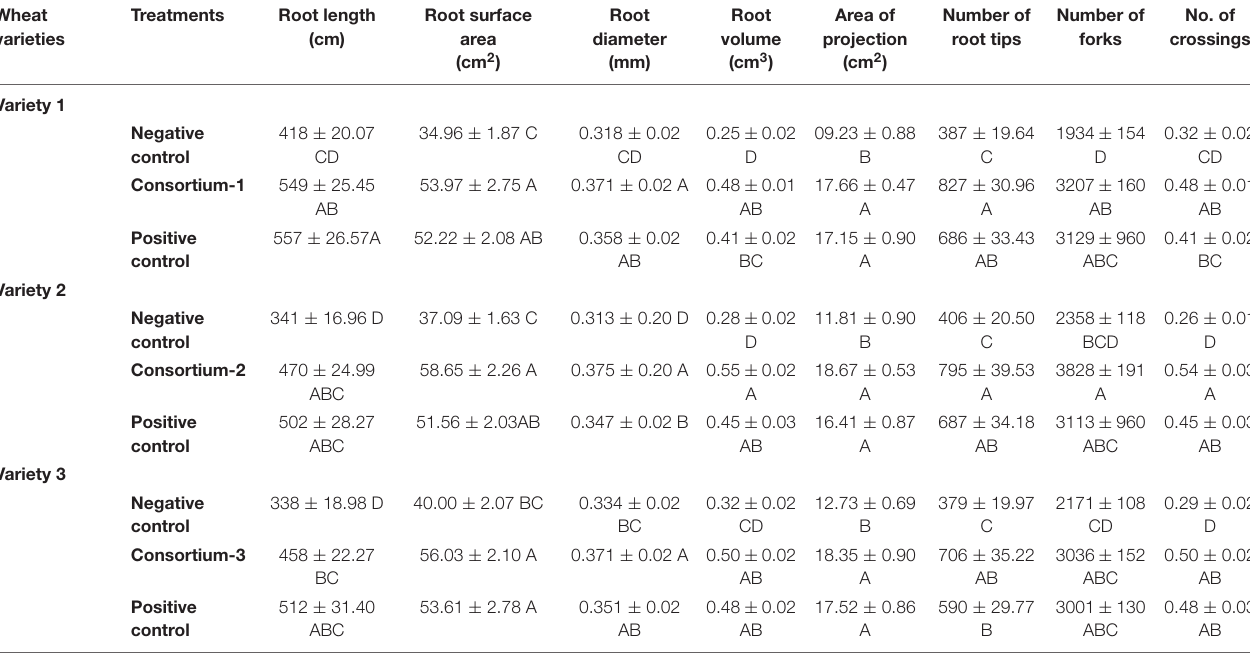
TABLE 3 | Effect of phosphate-solubilizing bacteria on root vigor index and morphological traits of hydroponically grown wheat varieties. Wheat varieties